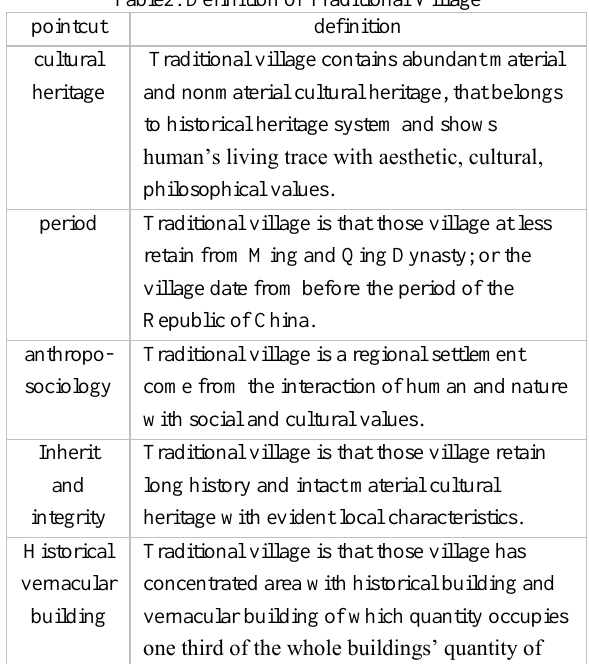
Table2. Definition of Traditional